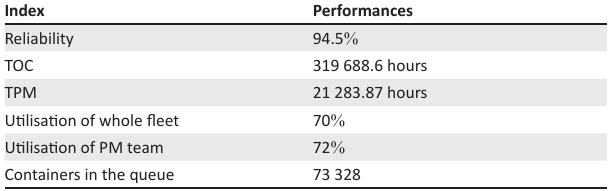
TABLE 11: Outcomes for adding two new straddles in lifting system.